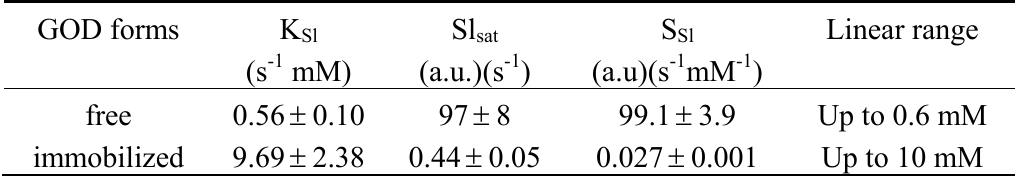
Table 3. Optokinetic parameters for free and immobilized GOD evaluated from fluorescence time course and from the analysis of the slope of signal intensity